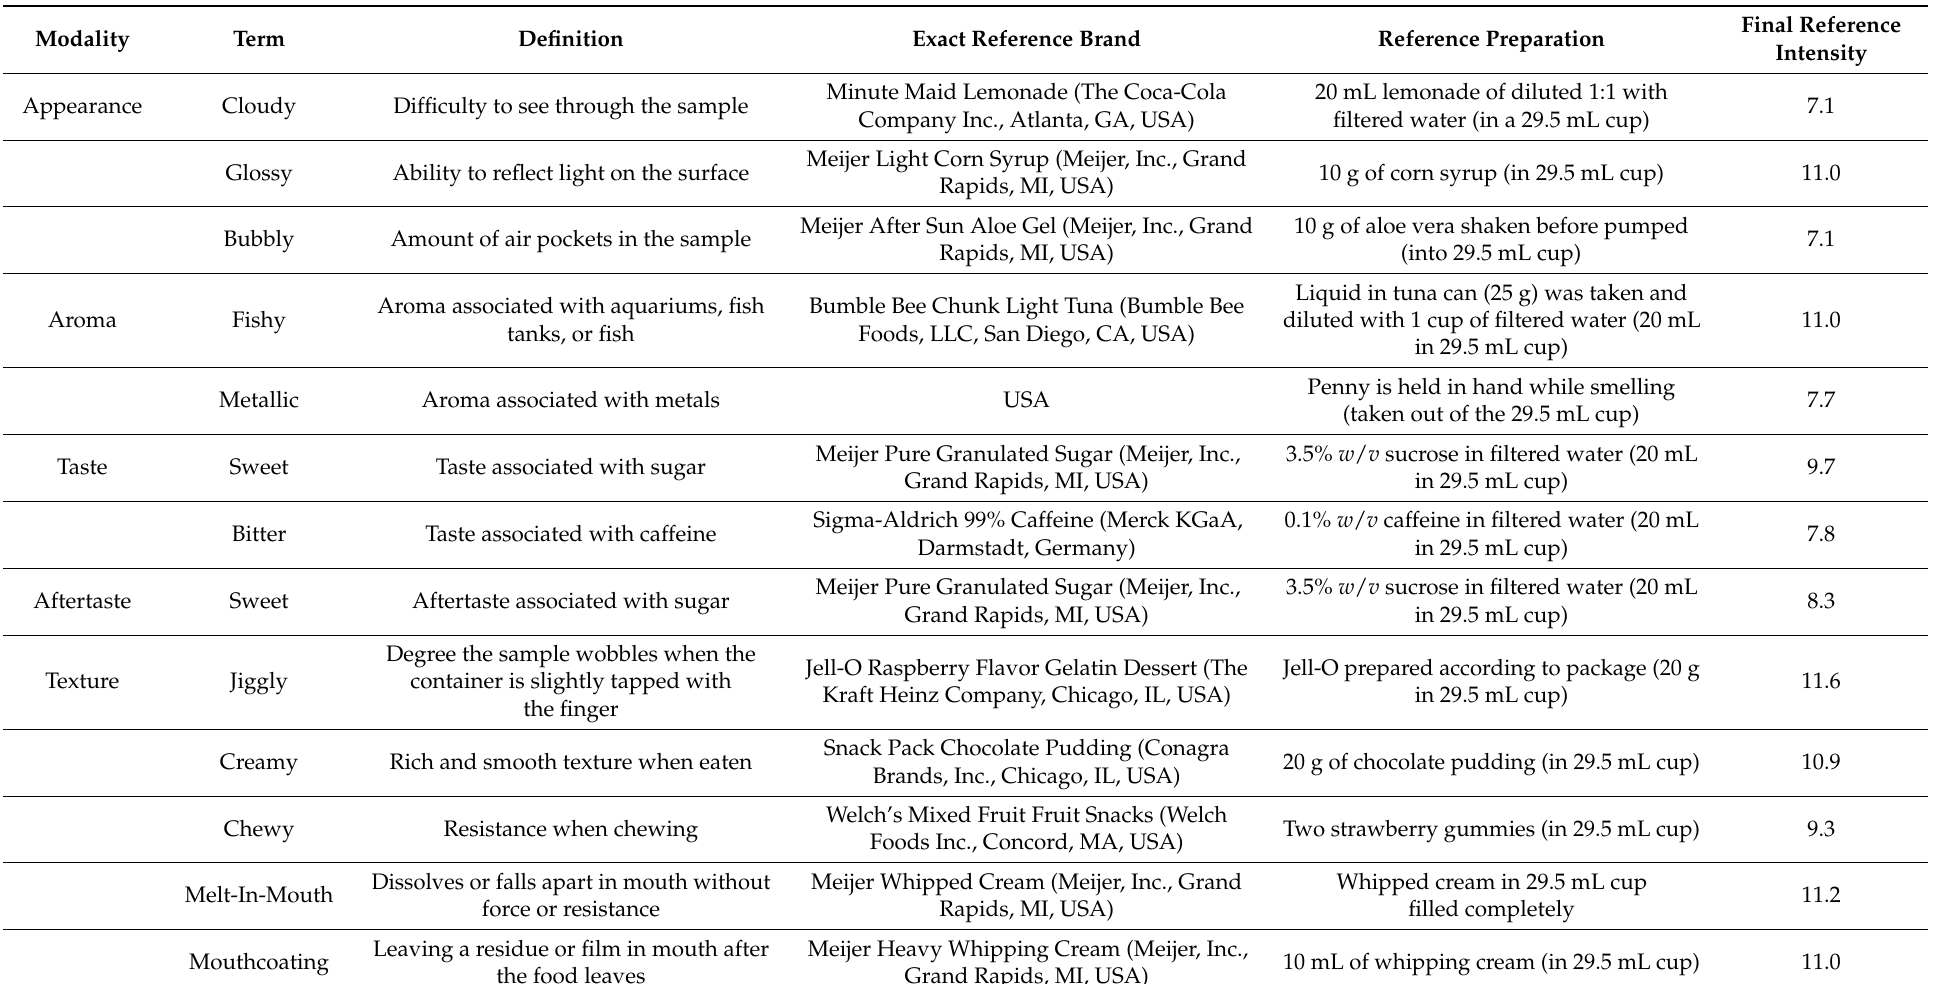
Table 1. Model confectionary gel attributes, definitions, reference brand, reference preparation and reference intensity developed by descriptive analysis